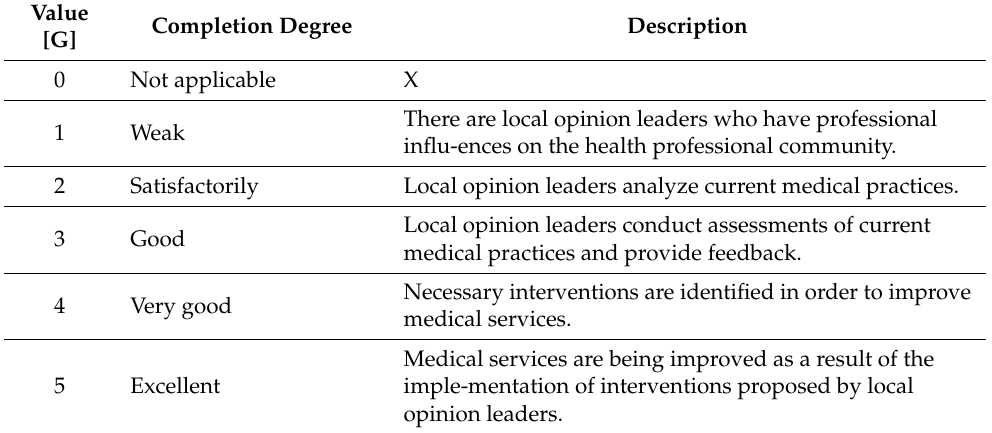
Table 14. Indicator evaluation grid E.A.2.—Evaluation of current medical practices.